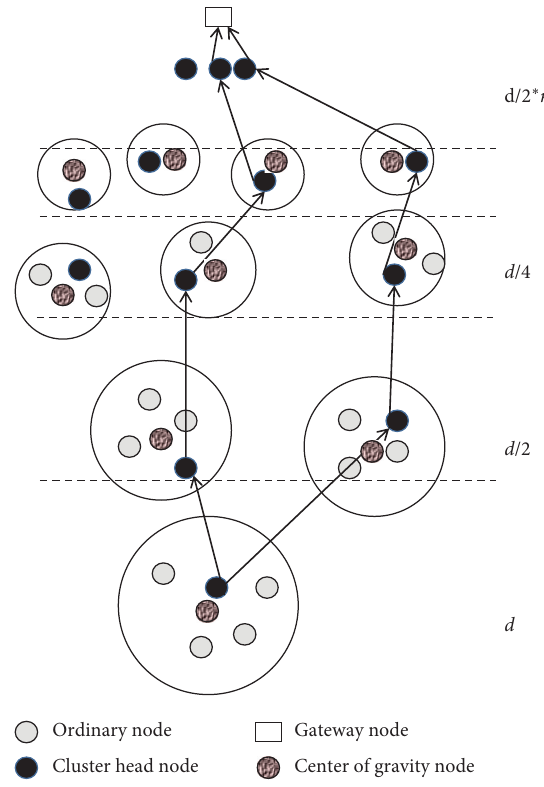
Figure 2: Diagram of the optimized LEACH protocol network